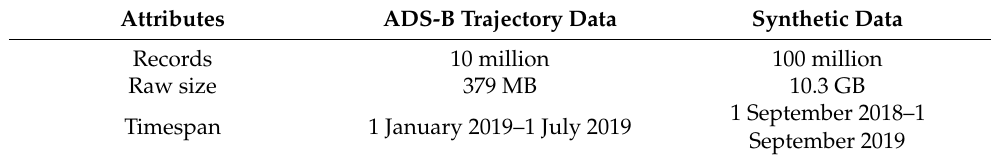
Table 3. The descriptions of datasets.